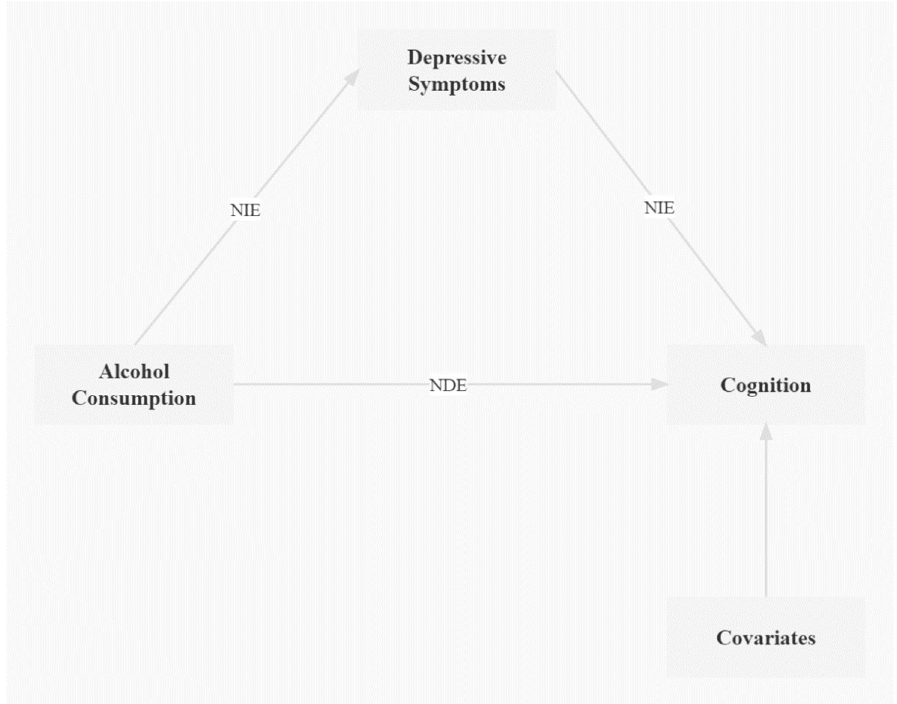
Figure 2. The model of mediation via depressive symptoms. Abbreviations: NIE, natural indirect effect; NDE, natural direct